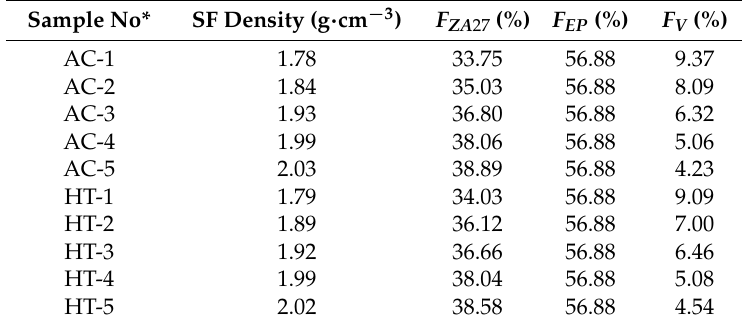
Table 1. Physical properties of the as-cast and heat-treated ZA27 syntactic